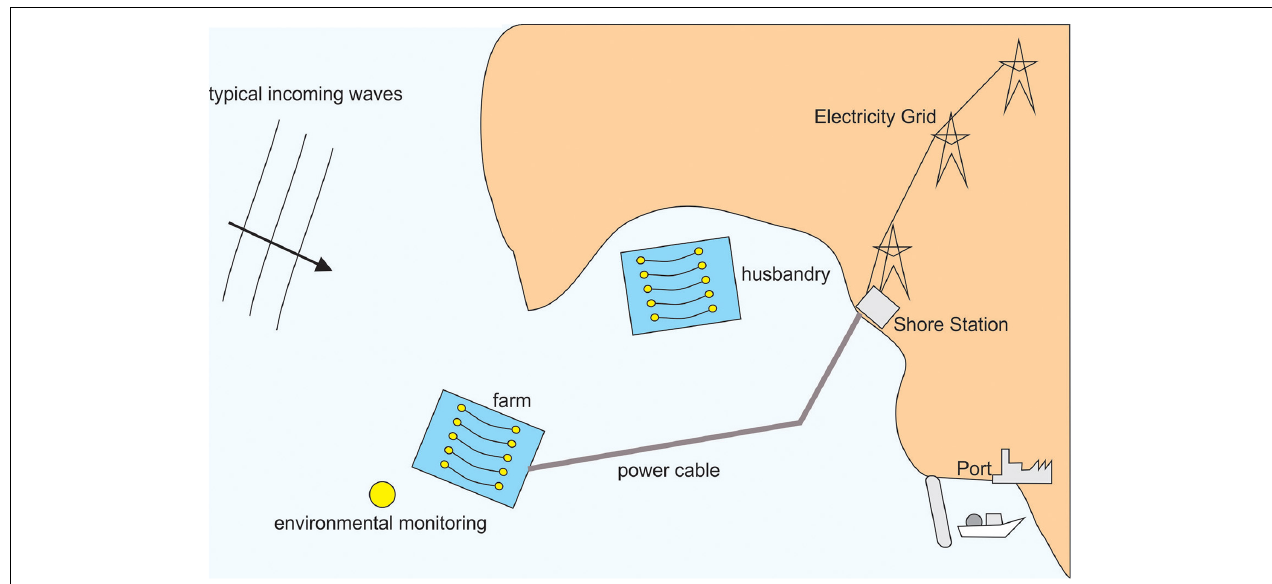
FIGURE 7 | Regional arrangement with the farm and its monitoring best placed to access the typical wave field. In addition, husbandry of the crop can take place somewhere sheltered. All of this then needs to be within reach of both electricity (grid) and marine infrastructure